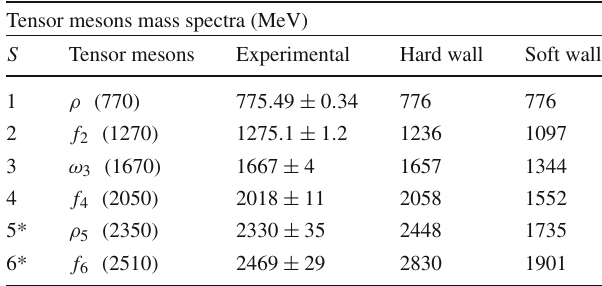
Table 1 Mass spectra for the tensor mesons family resonances. The particles with an asterisk are left out the summary table in PDG [49] Tensor mesons mass spectra (MeV) S Tensor mesons Experimental Hard wall